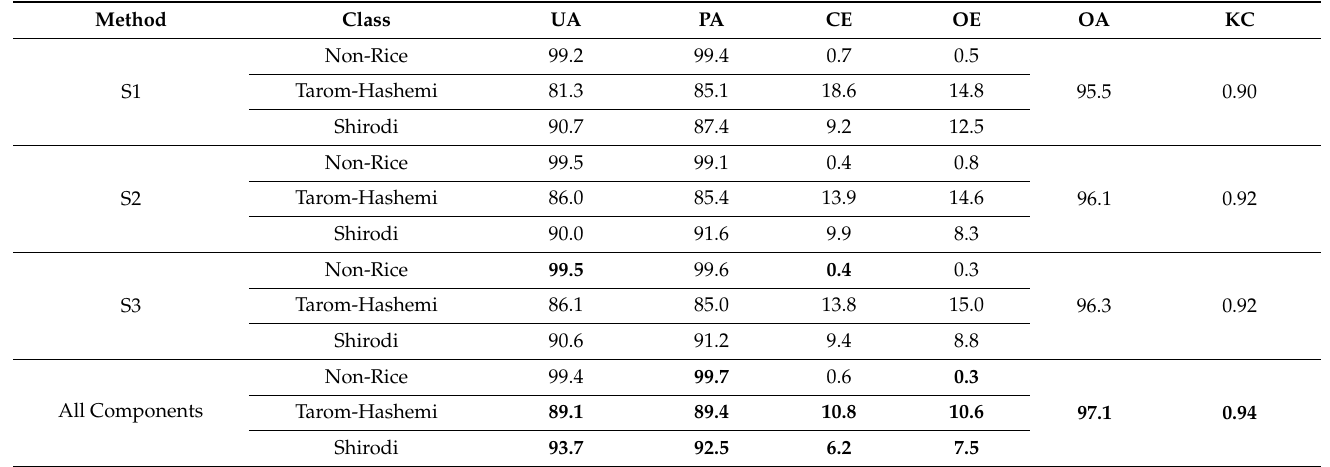
Table 4. Ablation analysis of proposed method in rice variety mapping. The bold values show the highest